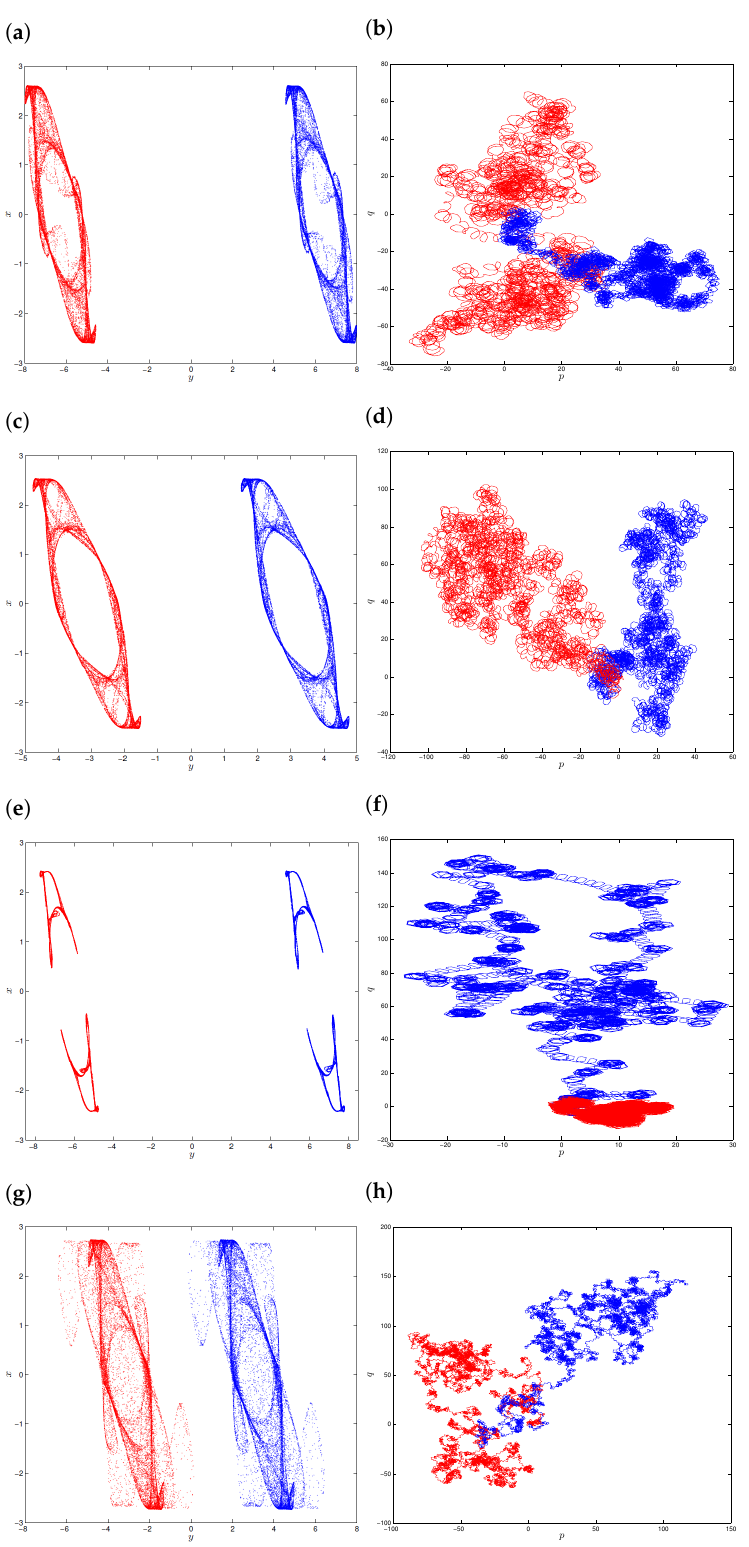
Figure 3. Hidden coexisting chaotic attractors and Brownian-like dynamics of the fractional memristor map (12) with infinite fixed points for ICs ( 1,2 ) and ( − 1, − 2 ) for fractional order α = 0.99 and system parameters a 2 = 1.1, a 3 = 0.001: ( a , b ) a 1 = − 2.75; ( c , d ) a 1 = − 2.5; ( e , f ) a 1 = 2.4; and ( g , h ) a 1 =